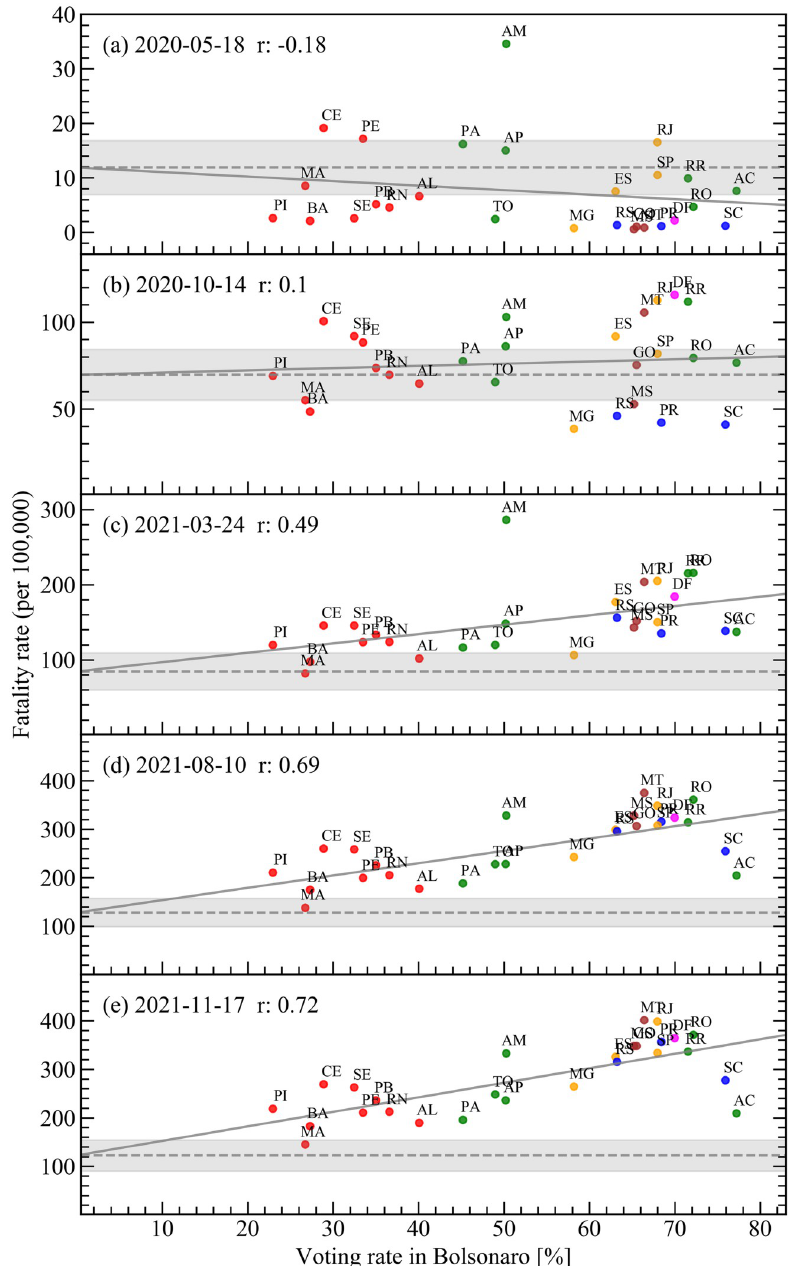
Fig 2. Distribution of fatality rates for all Brazilian states as a function of voting rate in the Brazilian president in the last election for five different days of the pandemic. The solid gray lines are linear fits to the data, and the dashed lines are the extrapolations to the fatality-rate level corresponding to a voting rate of 0%. The gray region is the error bar on the value of the dashed line. The colors for the state’s labels represent the same regions as in Fig 1. r is the value of the Pearson correlation coefficient for the distributions in each